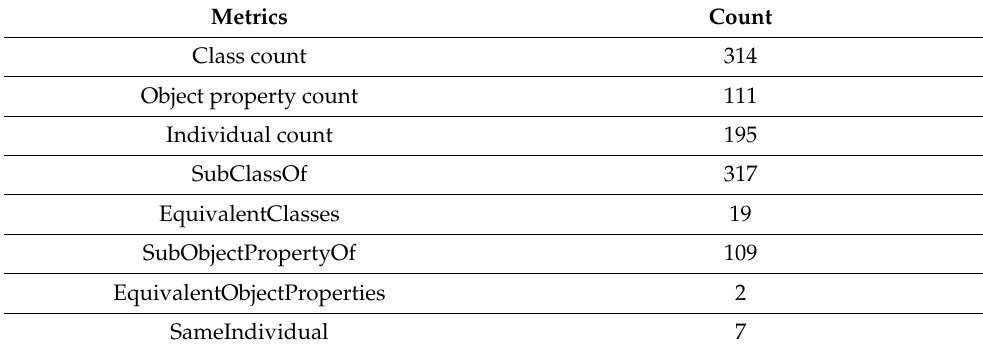
Table 4. Metrics of the concept ontology for residential building design codes.